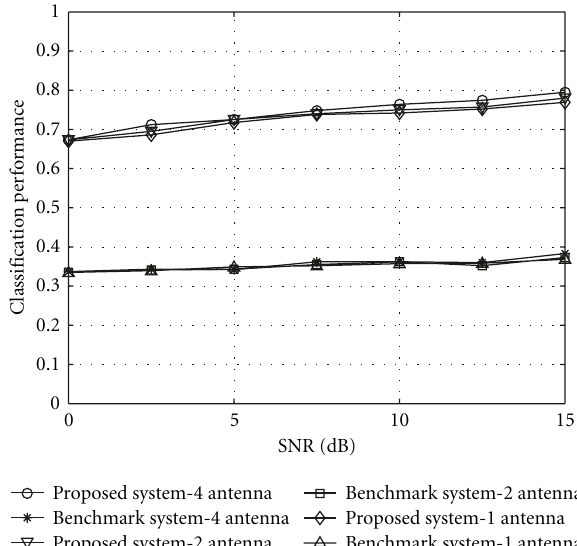
Figure 18: Classification performance of proposed initial SOF- based classification stage and benchmark in a faster varying flat fading channel with using the MRC-variant combining scheme.